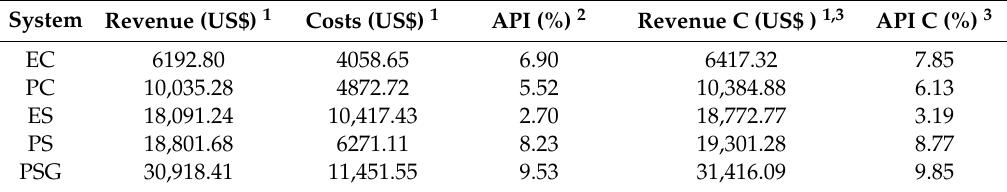
Table 3. Evaluation of financial